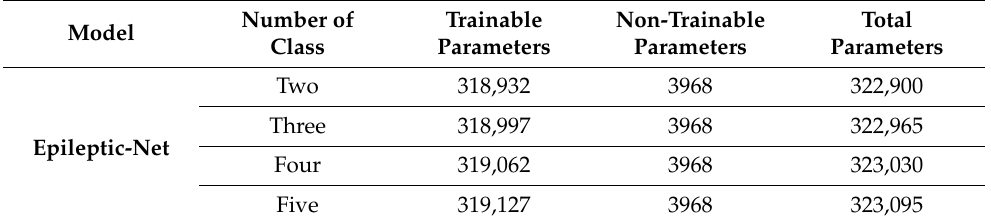
Table 6. Number of parameters of Epileptic-Net model for each